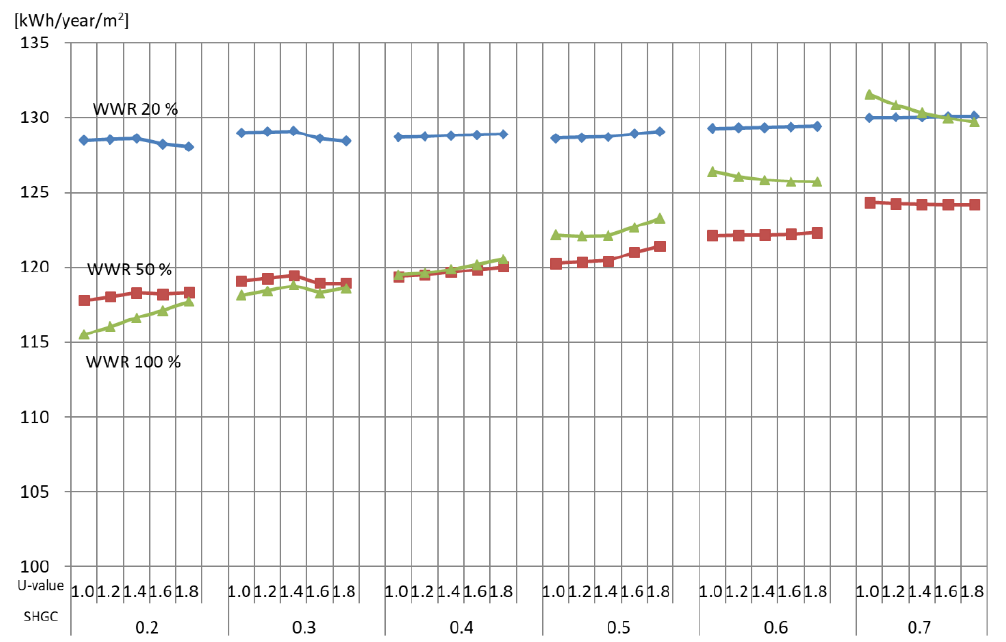
Figure 8. Energy demands/area according to the WWR and window properties 1.